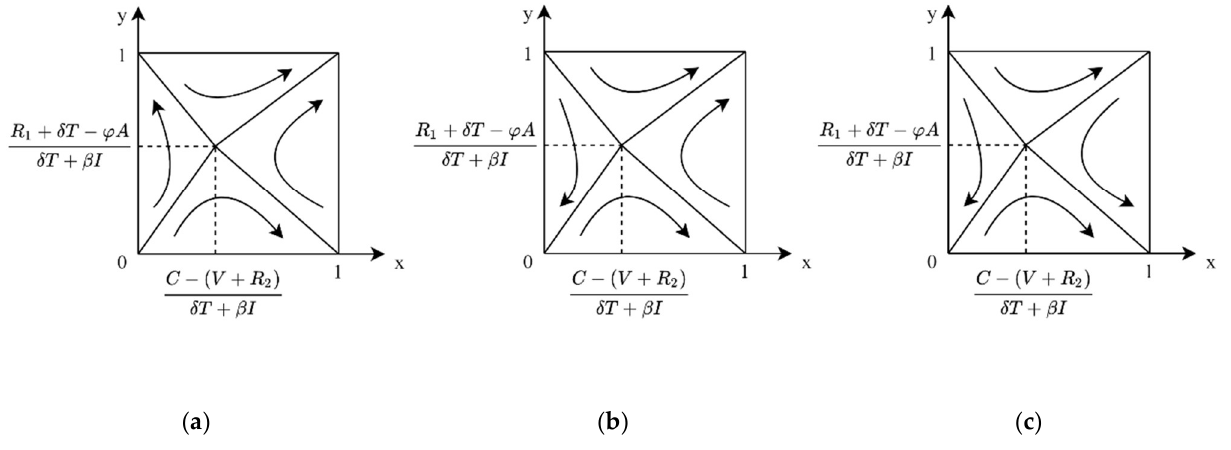
Figure 4. Evolutionary phase diagram of government cost–benefit under R 1 + δT - φA R&D costs are relatively low. ( b ) When R&D costs are somewhat high. ( c ) When R&D costs are high.